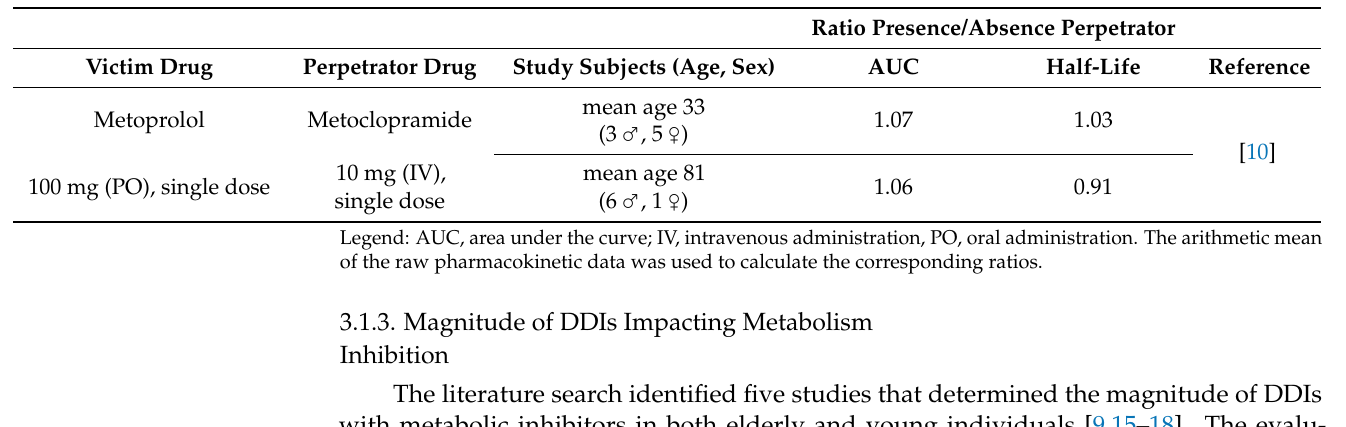
Table 1. Comparison of DDI magnitudes impacting absorption in elderly individuals relative to young